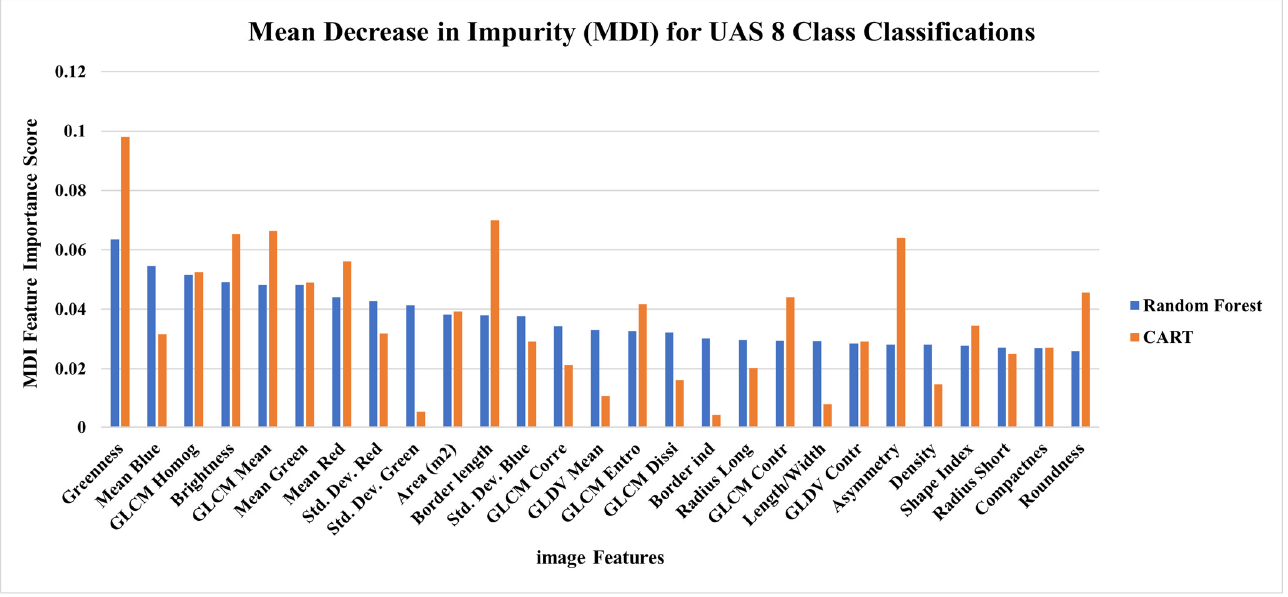
Figure A2. Feature importance for UAS imagery classification of eight composition classes calculated using the mean decrease in impurity (MDI) test. Table A3. Thematic map accuracy assessment error matrix for individual trees using the UAS imagery and the CART algorithm for eight classes.